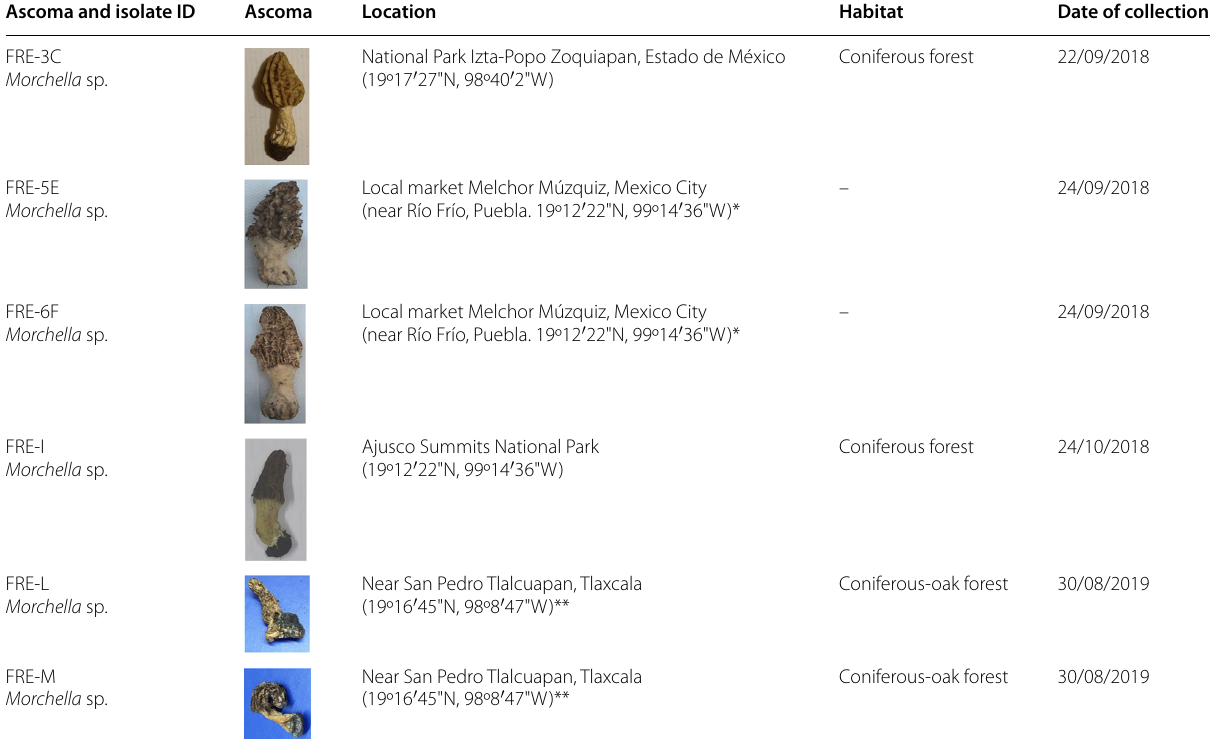
* Ascomata were bought in the local market Melchor Muzquiz commonly known as Mercado de San Ángel in Mexico City. According to the information provided by the seller the ascomata came from near Río Frio, Puebla ** Ascomata were donated at the V Festival for the Culture of Wild Mushrooms